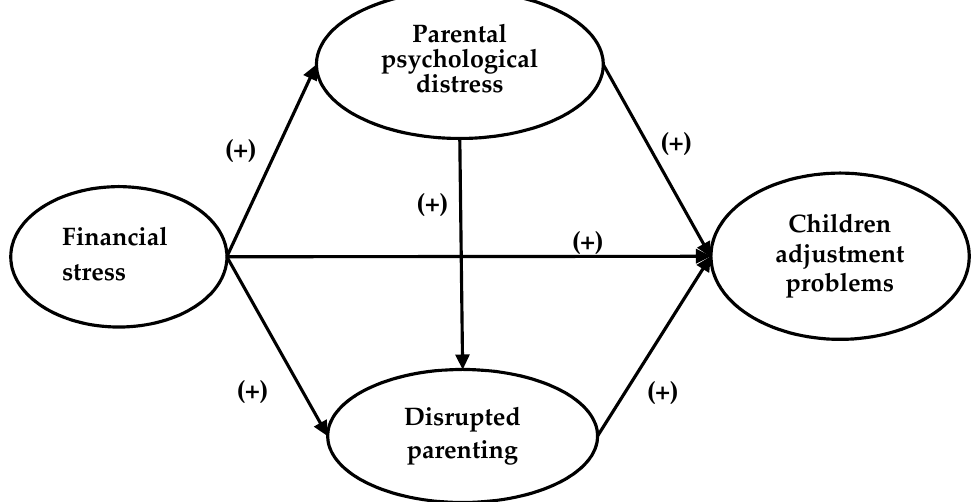
Figure 1. The Family Stress Model framework.